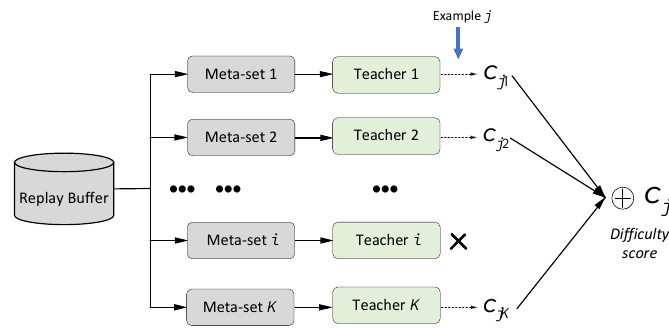
Figure 3. K-Fold priority function.